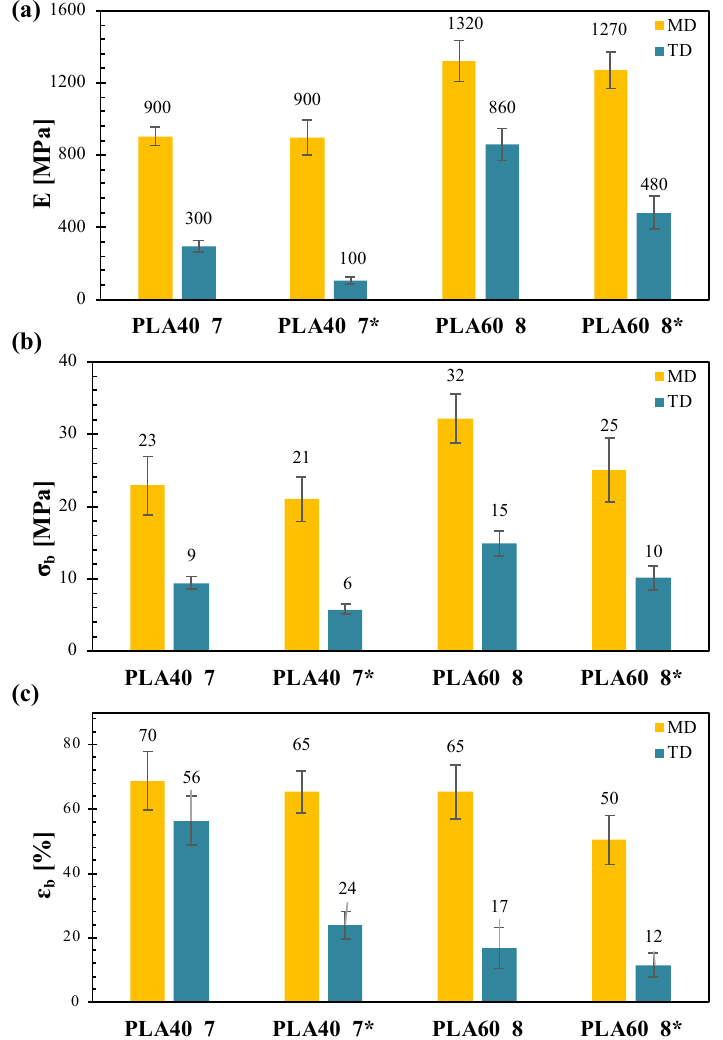
Figure 5. Tensile parameters of the films in MD and TD: ( a ) elastic modulus; ( b ) stress at break; ( c ) elongation at break (samples named with the asterisk were produced without cooling air).